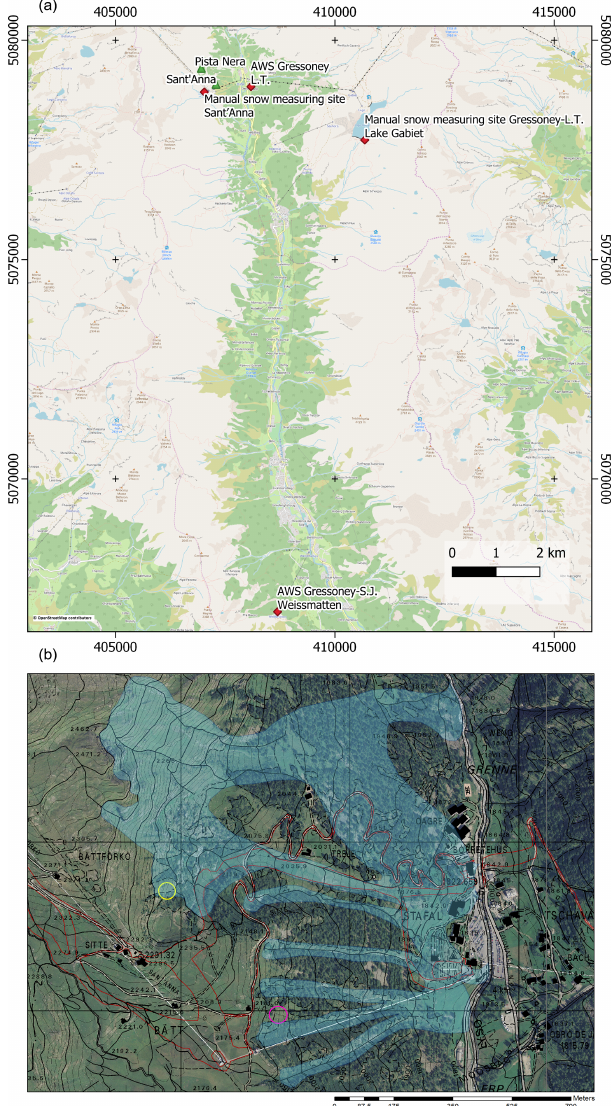
Figure 1. (a) Location of the two test sites (green triangles), the automatic weather stations and the manual snow measuring sites (red diamonds). Source: https://www.openstreetmap.org/copyright. © OpenStreetMap contributors 2019. Distributed under a Creative Commons BY-SA License. (b) Location of the two test sites “Pista Nera” and “Sant’Anna”, shown with the yellow and pink circles (in red the ski runs of the MonterosaSki resort are reported, while the light blue polygons represent the perimeter of the maximum avalanche events registered in the Avalanche Cadastre of the Aosta Valley